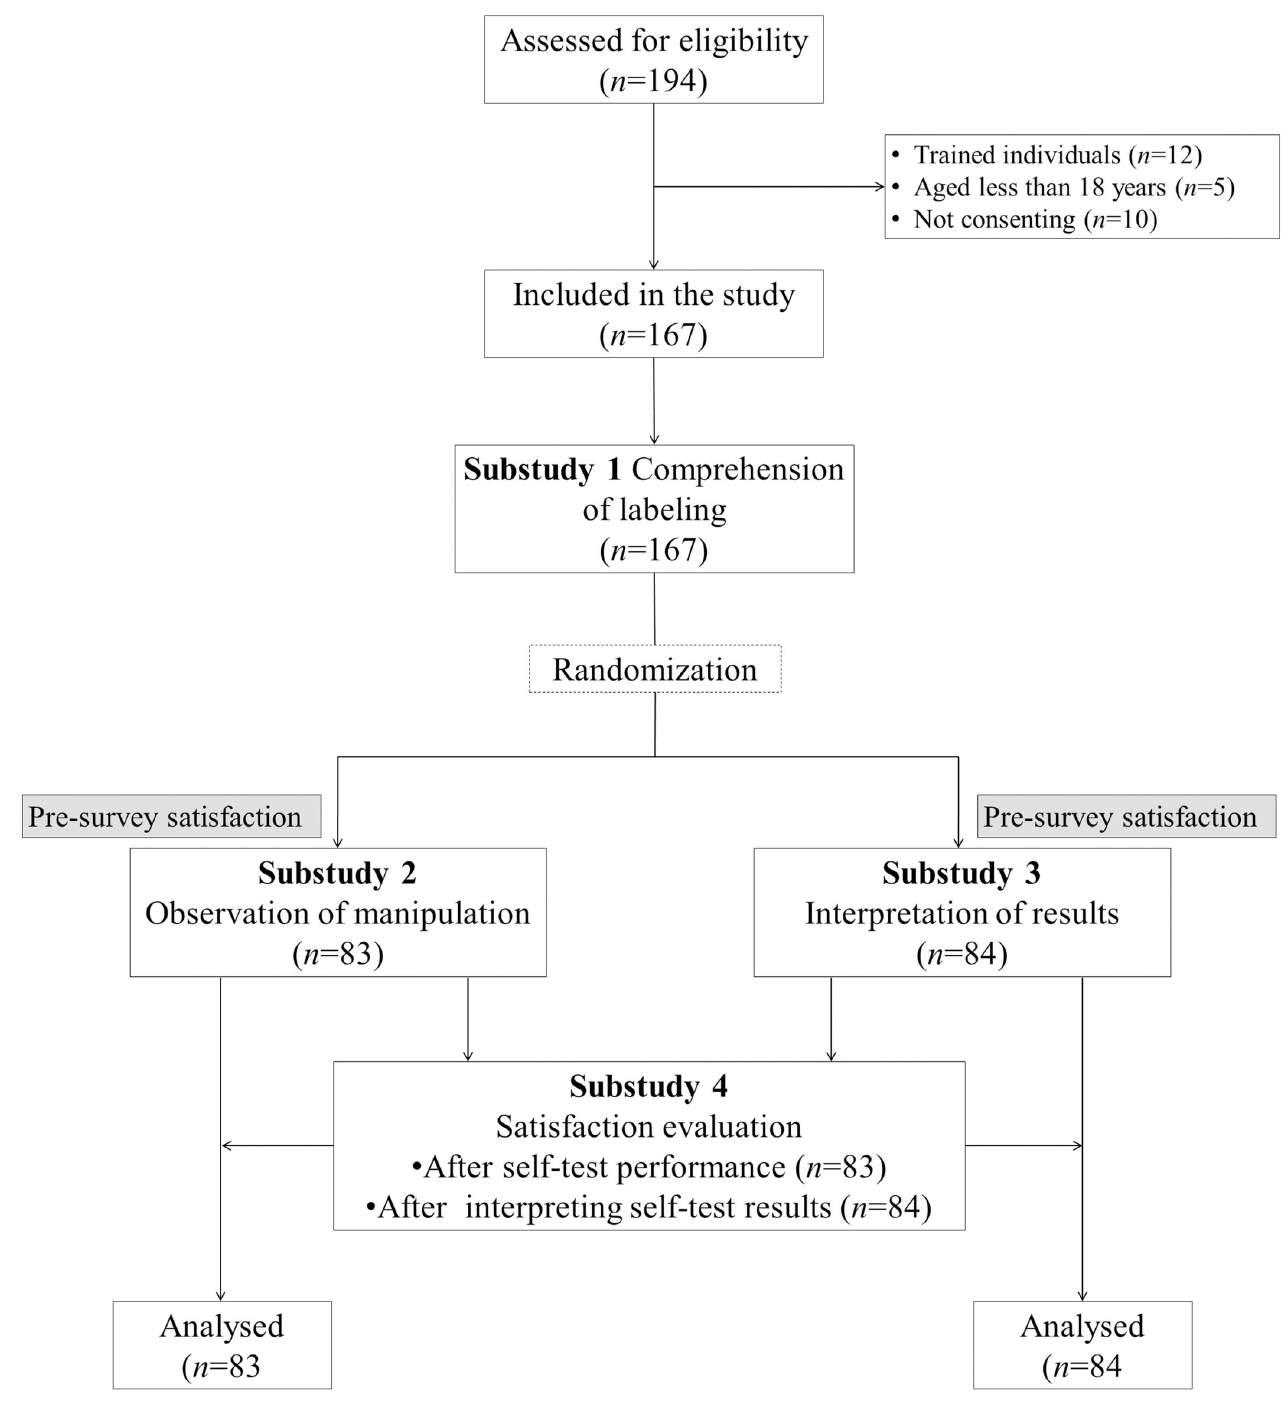
Fig 1. Flow chart showing the recruitment of study participants, their randomization, and affiliation for each substudy. https://doi.org/10.1371/journal.pone.0240779.g001 participants for interpretation after random selection of four tests (Fig 2). These standardized tests were coded by numbers to determine the expected results.